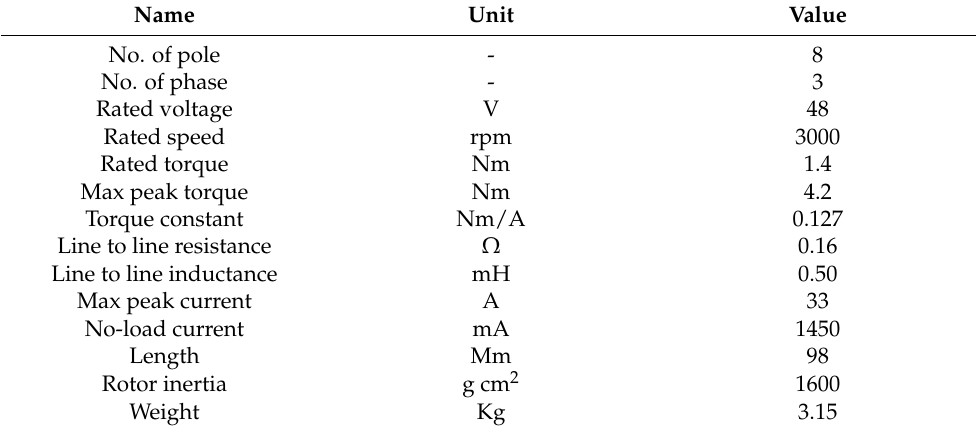
Table 1. Tested BLDC motor